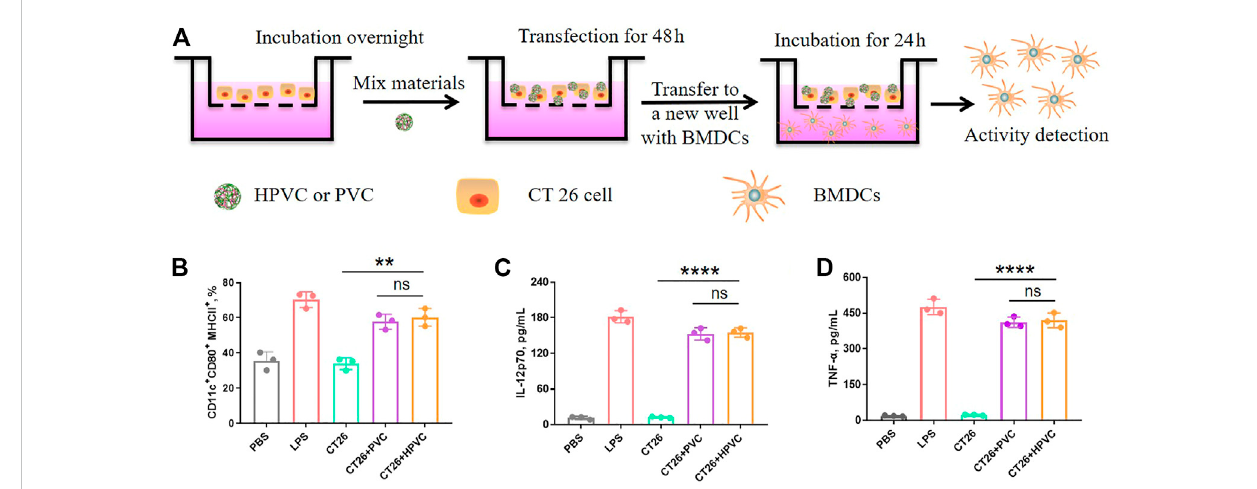
FIGURE 3 Invitro activation ofBMDCsbytranswellassay. (A) Strategyfor BMDCactivation invitro . (B) BMDCmaturationgatingon CD11c + CD80 + MHCII + cells. (C) IL-12p70 and (D) TNF- α cytokine secretion in the medium. ns = no signi fi cance, ** p <